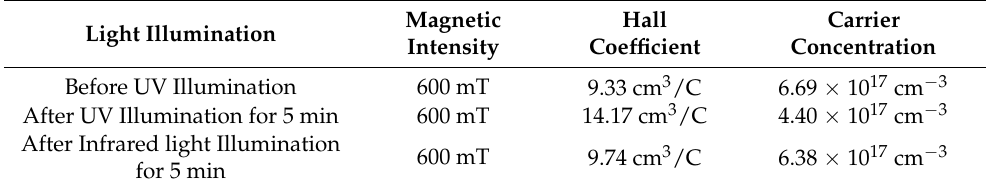
Figure 5. ( a ) Schematic illustration of the physical picture of deep electron traps and deep hole traps assisted light-induced degradation after UV light exposure; ( b ) Schematic illustration of the physical picture of the healing of light-induced degradation after infrared light exposure. Table 2. Hall coefficient and carrier concentration of the Mg-doped GaN thin film before and after UV or infrared light exposure.